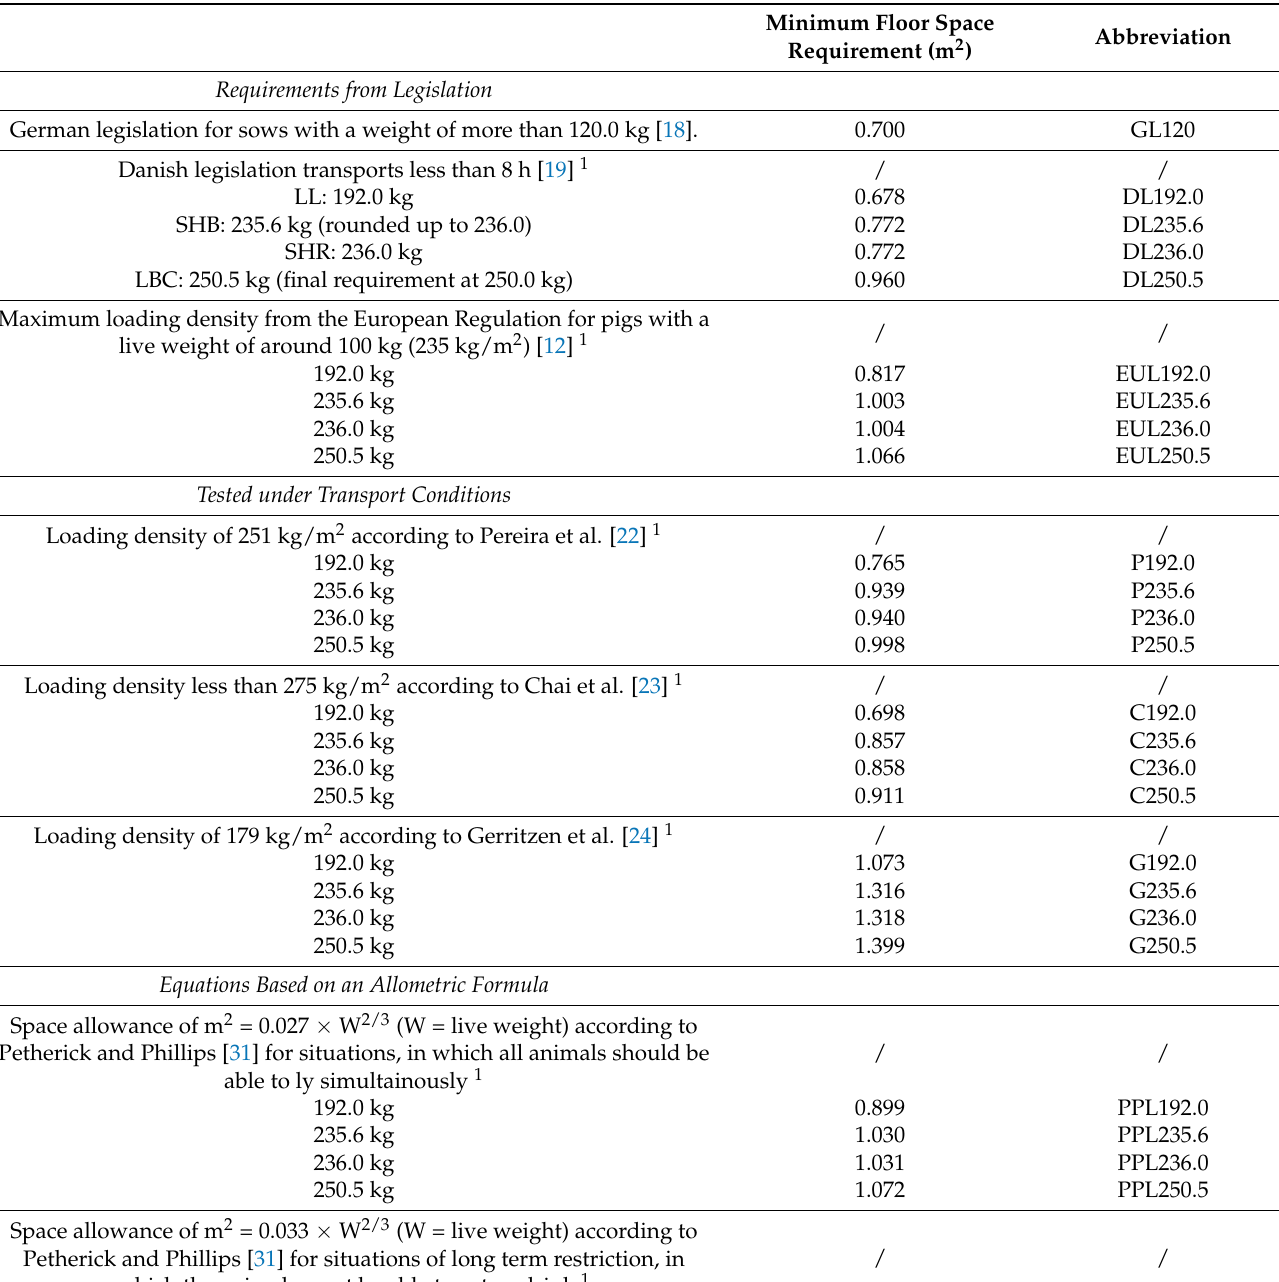
Table 4. Loading densities and minimum floor space requirements used for comparison with covered floor areas measured for